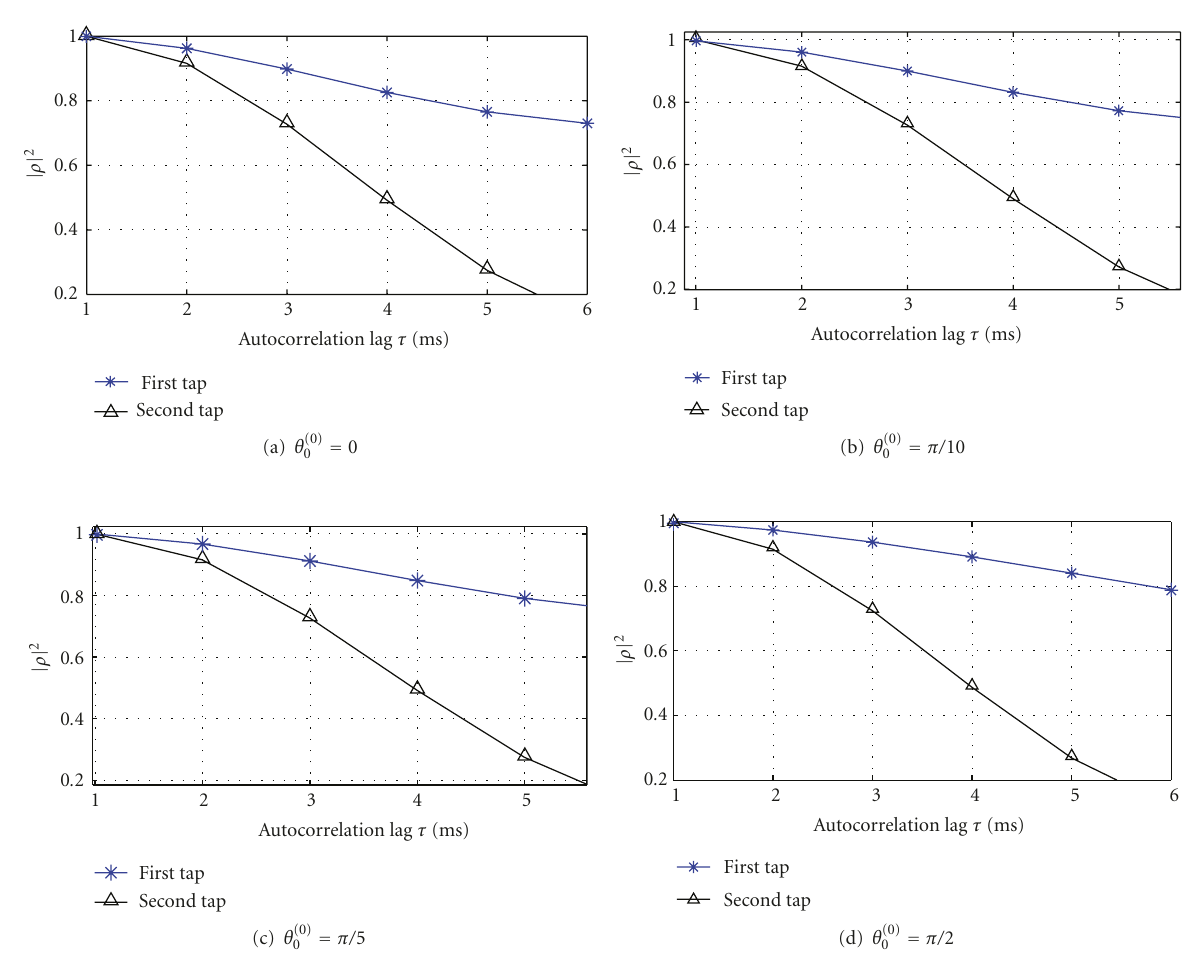
Figure 3: Squared-envelope of the autocorrelations of first and second taps for common parameters K 0 = 10, v = 20m/s, and the set of AoAs { θ (0) 0 }